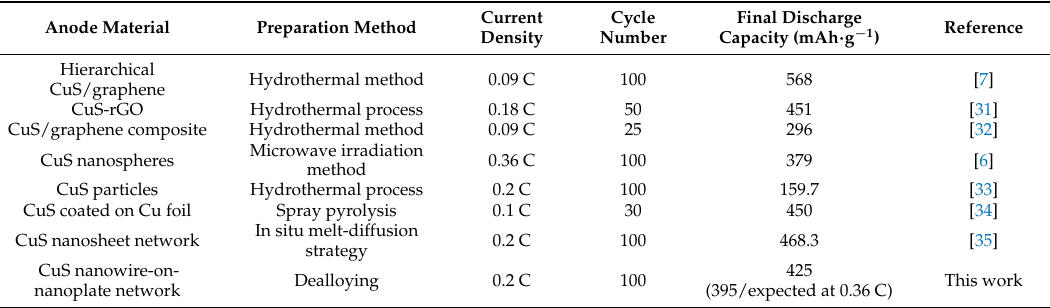
Table 1. Comparative performance of CuS anodes for LIBs